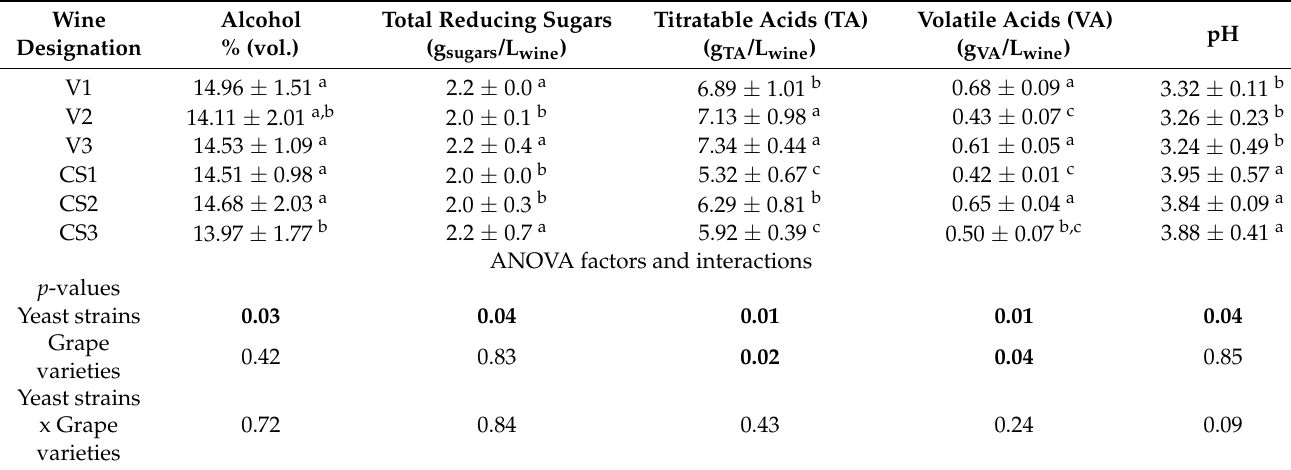
Table 4. Mean values and standard deviations (mean ± STDV) of oenological parameters of wines from Vranec and Cabernet Sauvignon grape varieties and fermented by autochthonous and commercial yeast strains. Wine type abbreviations are defined in Table